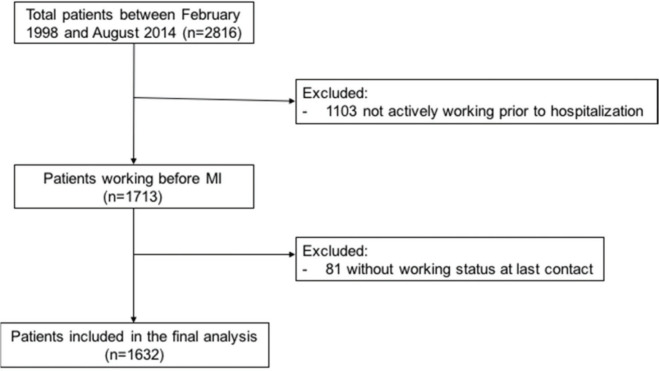
Flowchart of the study patients.